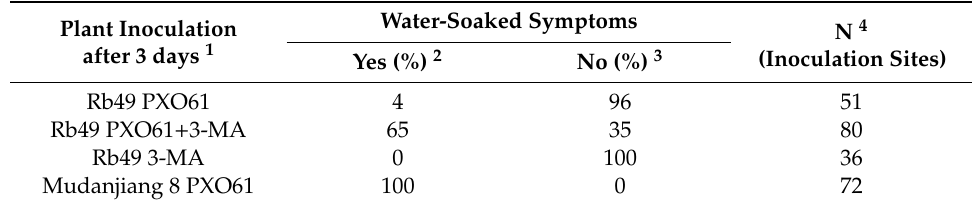
Percentage of infiltrating inoculation site with water-soaked symptoms influenced by 3-methyladenine. Plant